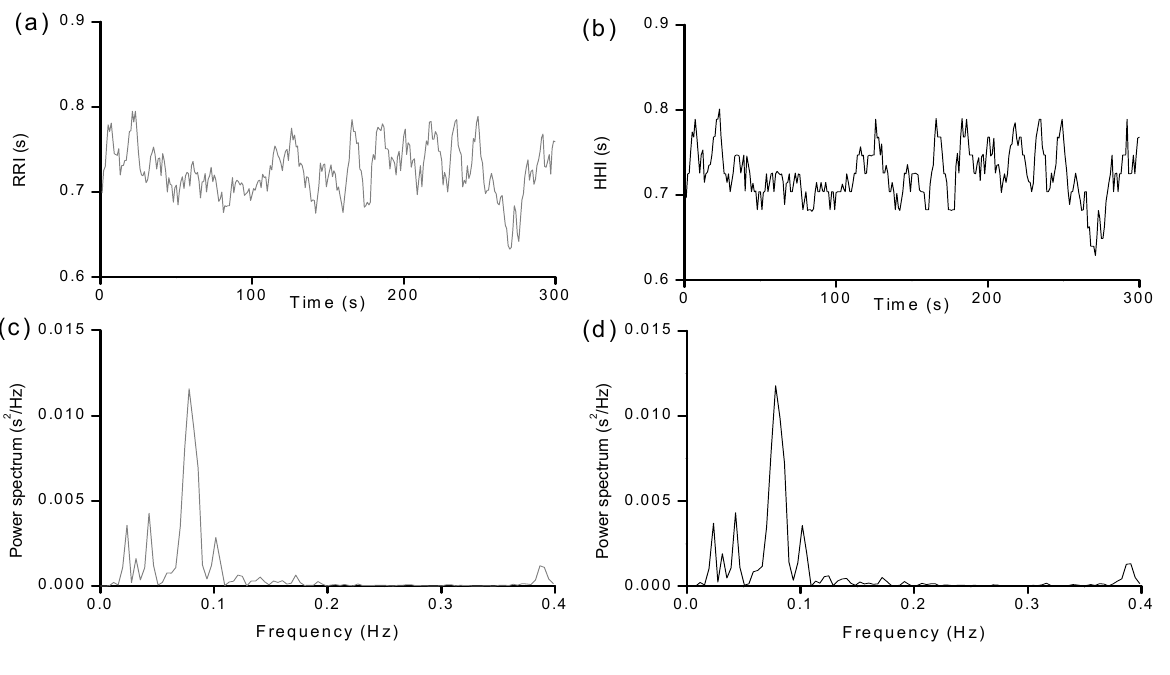
Figure 3. RRIs and HHIs with their power spectrum analysis. Left column is the RRIs derived from the ECG recordings; right column is the HHIs derived from heartbeat recordings. The top panels indicate the RRIs and HHIs ((a)-(b)). The lower two panels show the power spectrum of RRIs and HHIs